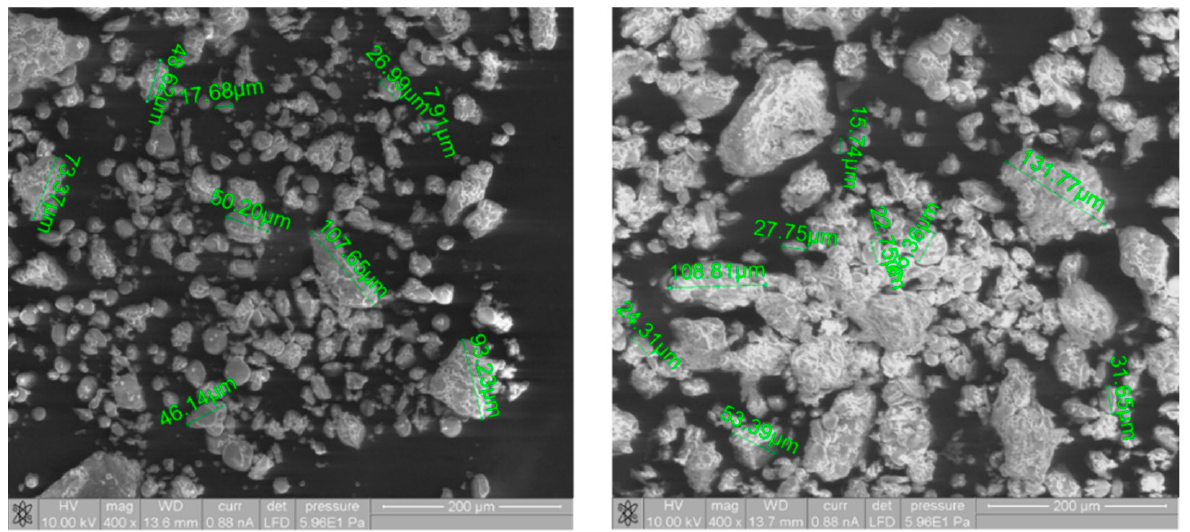
Figure 3. Environmental Scanning Electron Microscopy (ESEM) images of native white wheat flour (left) and white wheat flour after scCO 2 treatment (right) at a magnification of 400×.